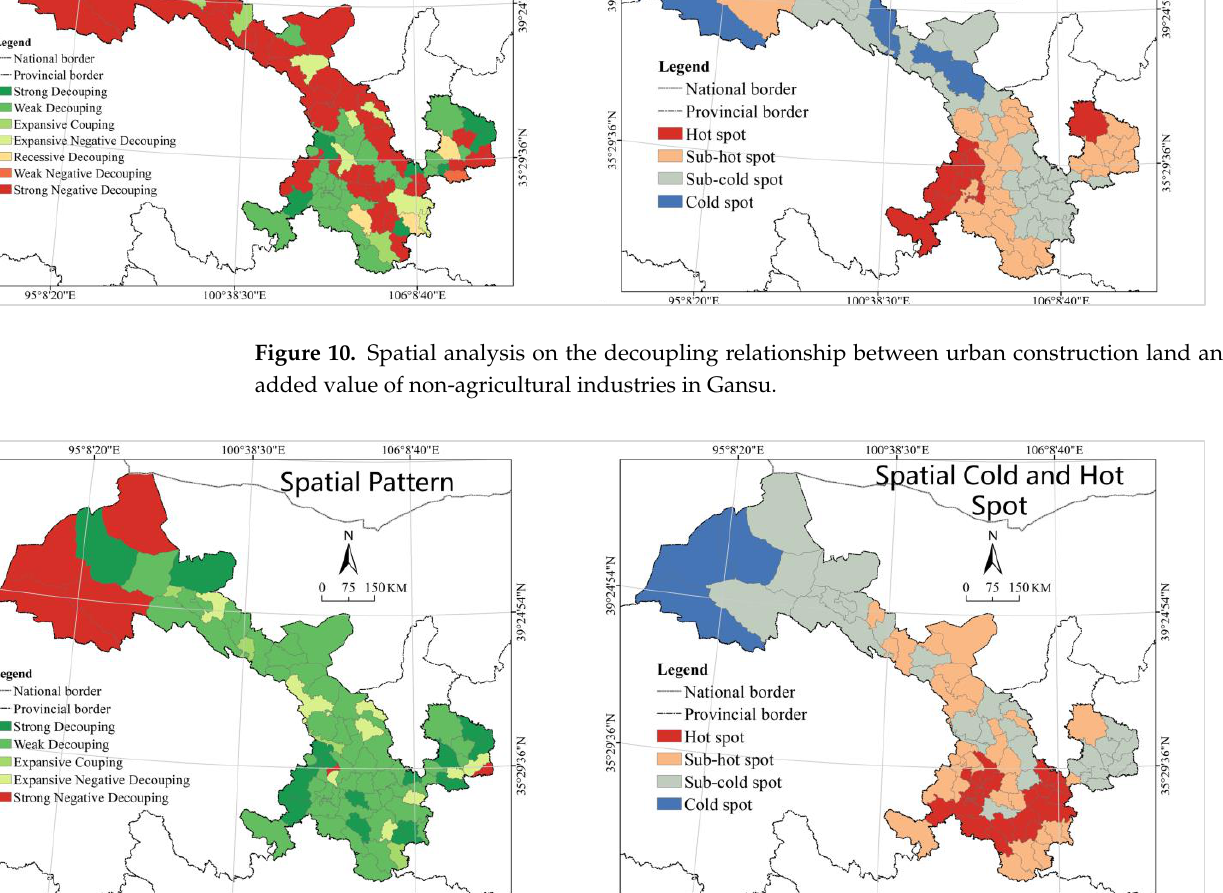
Figure 11. Spatial analysis on the decoupling relationship between urban construction land and per capita GDP in Gansu.